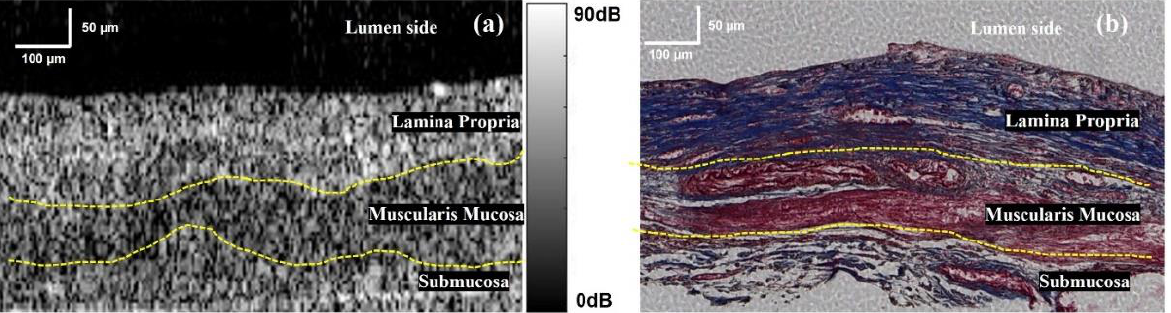
Figure 3. OCT structure image ( a ), and corresponding histology results ( b ), respectively. The yellow dashed lines indicate the boundaries between each layer.